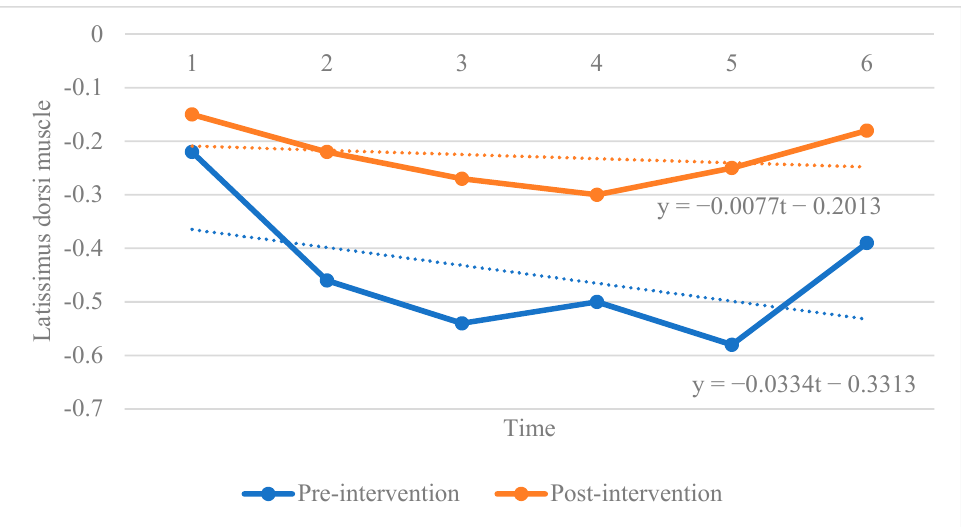
Figure 4. The effect of instrument intervention on number 1 athlete.